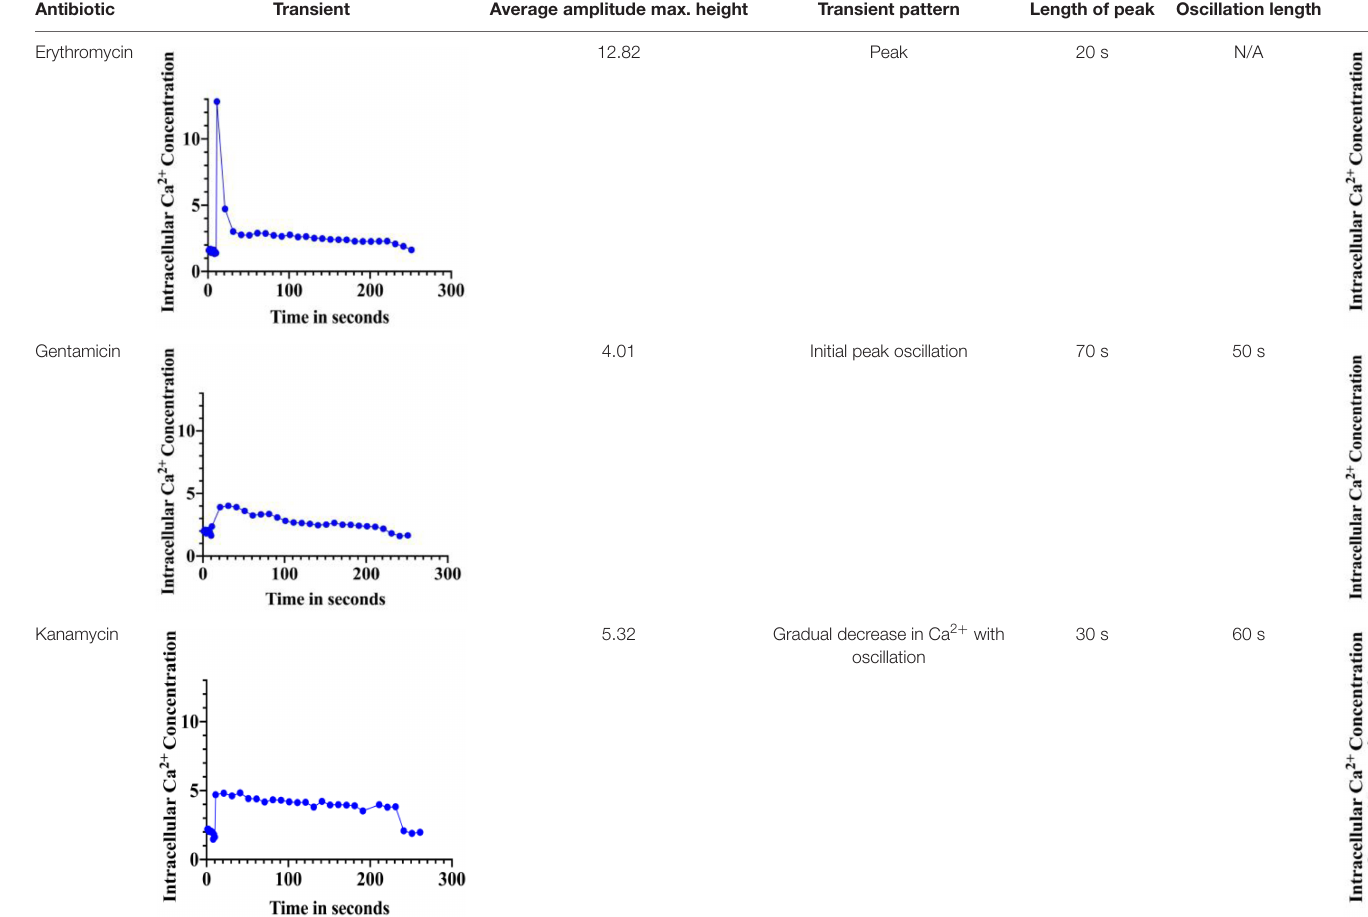
TABLE 1 | Distinct Ca 2 + -mediated signals in response to various antibiotics.